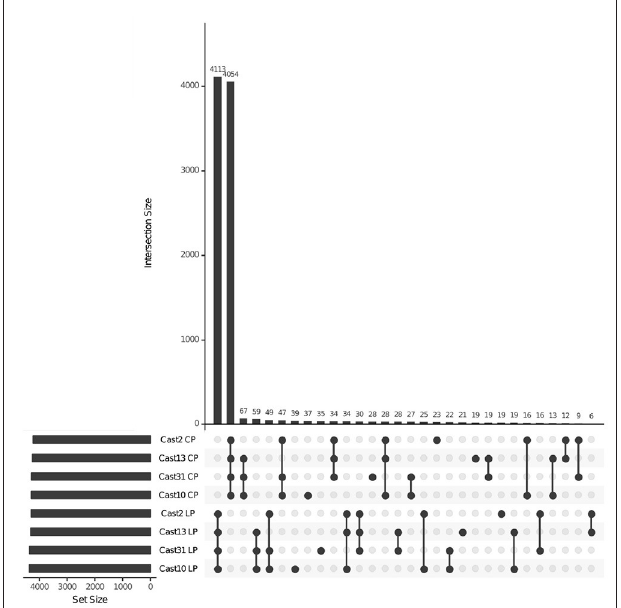
FIGURE 5 | UpSet plot showing homoeologs mapping both DNA and RNA reads across T. castellanus individuals. Set IDs represent samples where homoeologs from T. crocifolius (C) or T. lamottei (L) are present (P) based upon both DNA and RNA alignment. Overlapping sets are indicated by filled circles, and the number of loci within that intersection may be seen directly above in the bar chart with corresponding size over each bar. The total sample sizes are found in the left bar chart and correspond to the adjacent sample. As expected, there should be no overlap across T. crocifolius and T. lamottei homoeologs.